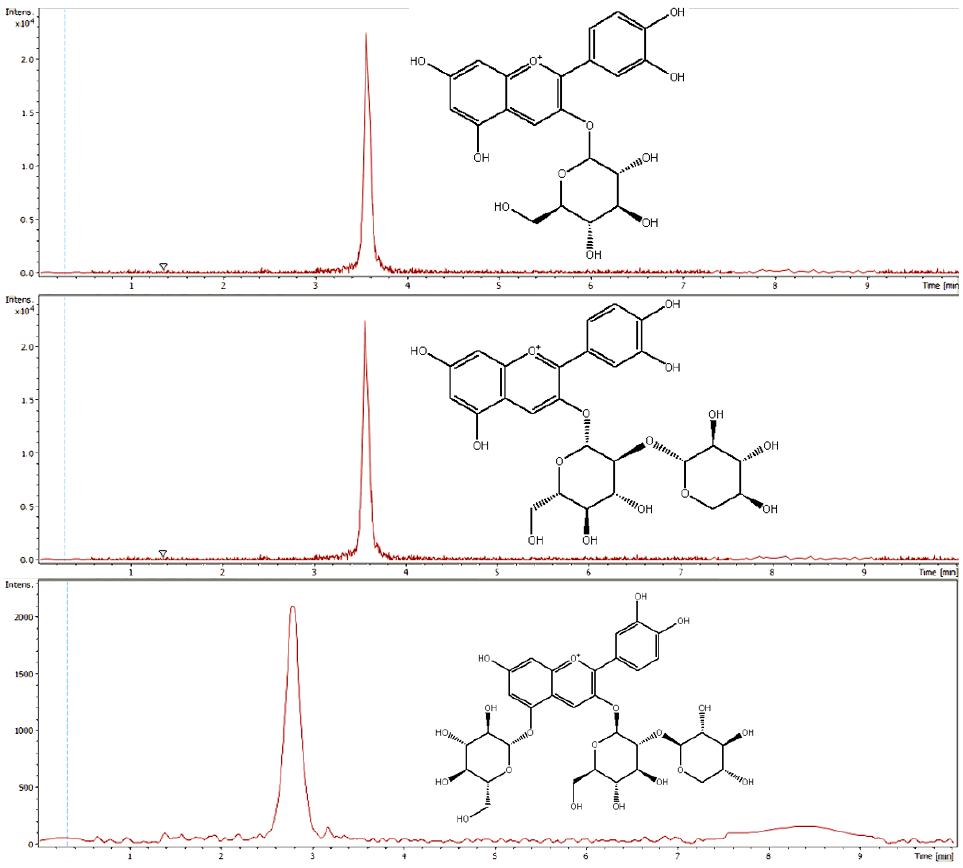
Figure 3. Extracted ion chromatograms of cyanidin-3-O-glucoside, cyanidin-3-O-sambubioside and